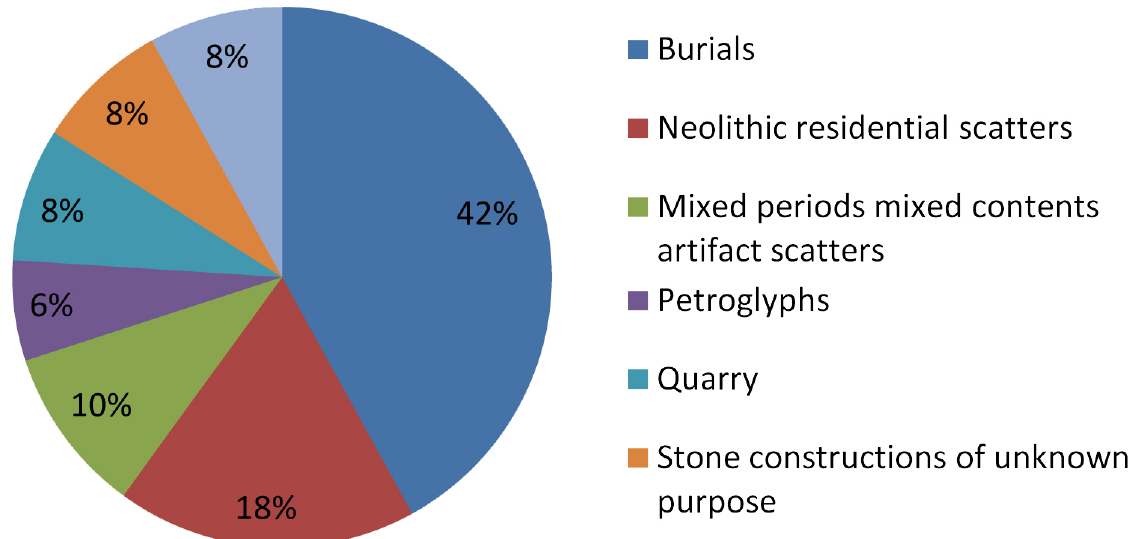
Figure 2. Distribution of site types identified at Ikh Nart from the random sample and the projected proportion of those identified as having “Neolithic”